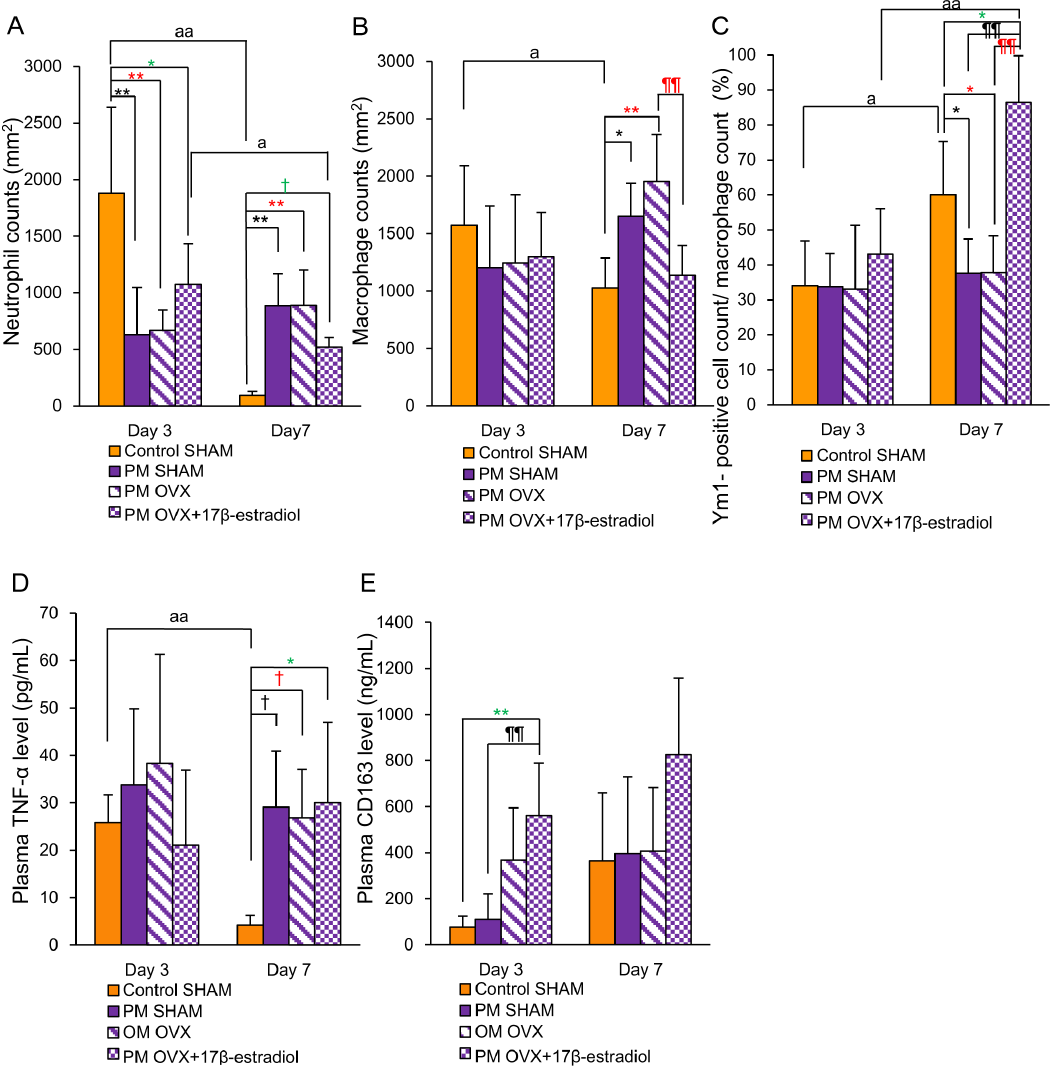
Fig. 4. Neutrophils, macrophages, Ym1-positive cell count/macrophage count (%), plasma TNF- a and plasma CD163. (A) The number of neutrophils per mm 2 , (B) the number of macrophages per mm 2 , (C) Ym1-positive cell count/macrophage count (%), (D) systemic TNF- a level and (E) systemic CD163 level are shown on box graphs. Values are expressed as mean ¡ SD, n 5 4–6 for each group, ANOVA, Tukey-Kramer { p , 0.1, * p , 0.05, ** p , 0.01 (in black): Control SHAM versus PM SHAM, { p , 0.1, * p , 0.05, ** p , 0.01 (in red): Control SHAM versus PM OVX, { p , 0.1, * p , 0.05 (in green): Control SHAM versus PM OVX + 17 b -estradiol, "" p , 0.01 (in black): PM OVX + 17 b -estradiol versus PM SHAM, "" p , 0.01 (in red): PM OVX + 17 b -estradiol versus PM OVX, and t-test a p , 0.05, aa p , 0.01: day 3 versus day